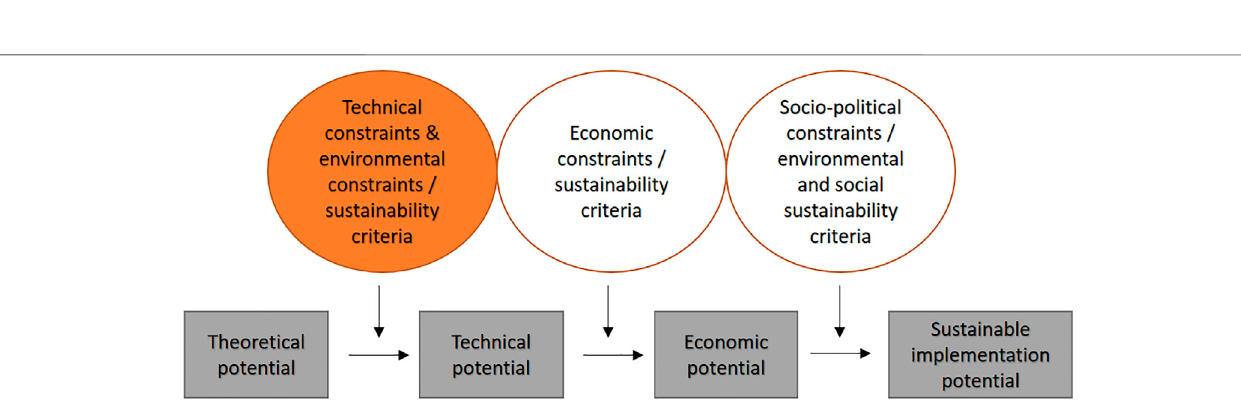
Frontiers in Energy Research |